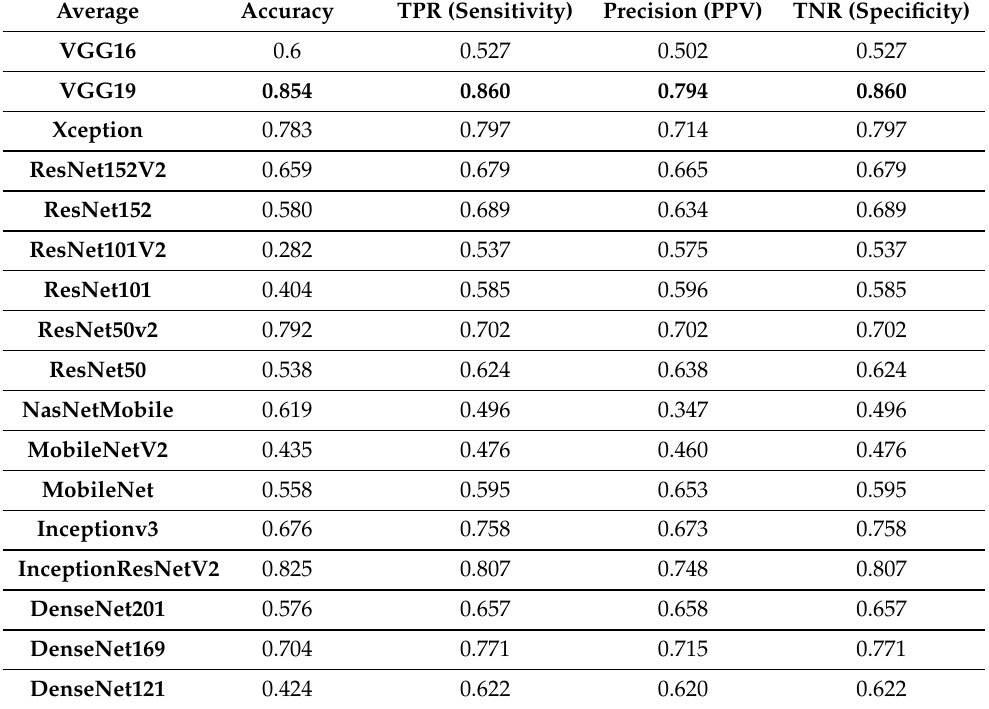
Table 2. Average metric results related to the raw